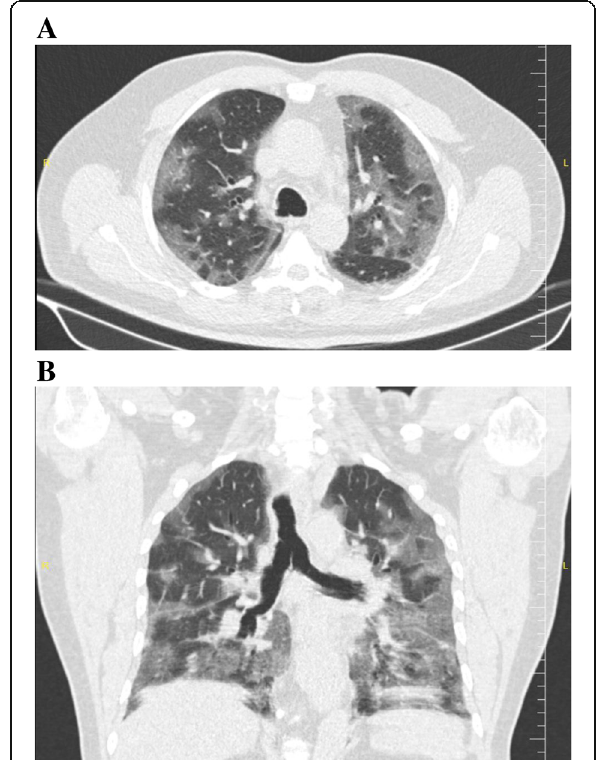
Fig. 4 Axial unenhanced chest CT image ( a ) and coronal reconstructed unenhanced chest CT image ( b ) from a 57-year-old man with COV İ D-19 pneumonia noted widespread ground-glass and consolidative opacities in both lungs with a bilateral, peripheral, and basal predominant distribution